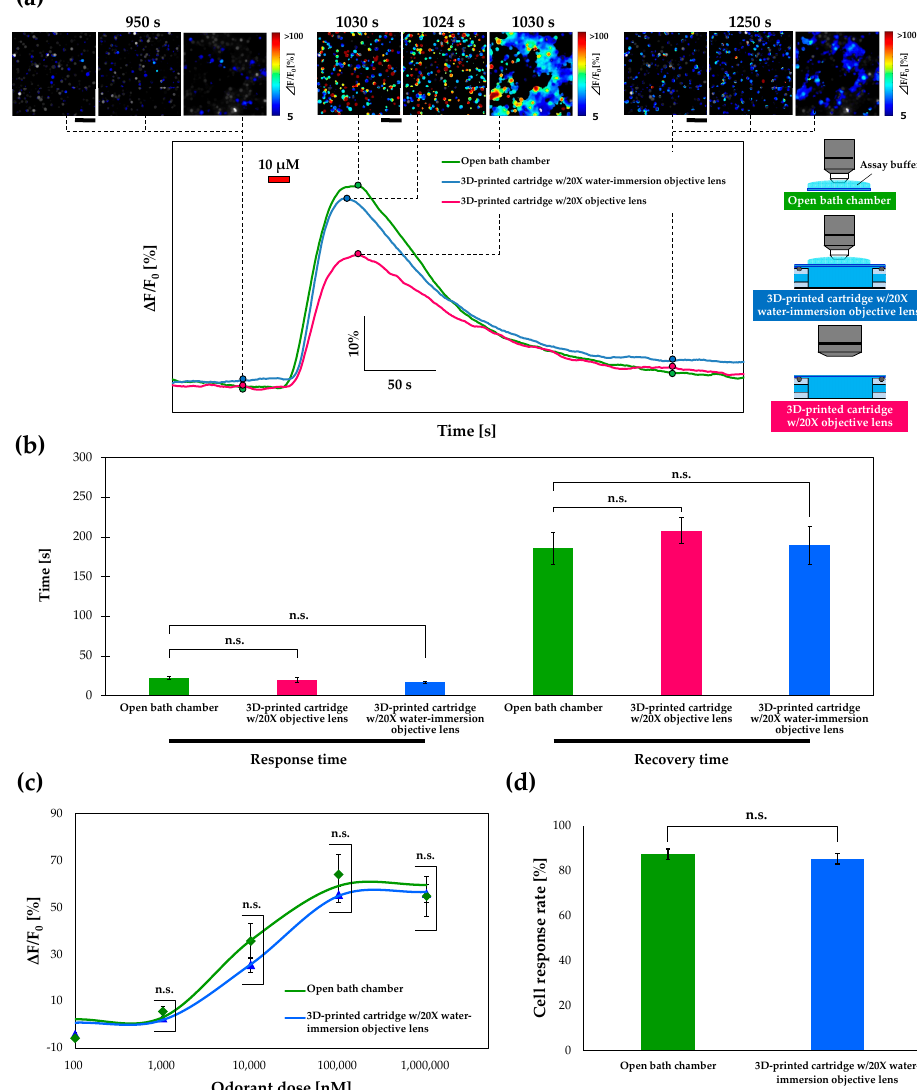
Figure 5. ( a ) Typical fluorescent response of the Or13a cells using the 3D-printed cartridge and a commercial open bath chamber when 10 μ M 1-octen-3-ol stimulations were applied. Upper pseudo- color heat maps of cell-response rates (before stimulation, the peak of fluorescent intensity change, and after stimulation) in a commercial open bath chamber and the 3D-printed cartridge with a 20× water-immersion objective lens or a 20× objective lens exhibited a > 5% increase in fluorescence intensity from the baseline. We defined the start time as 0 s. ( b ) Comparisons between the average response and recovery times for Or13a cells in a commercial open bath camber and in the 3D-printed cartridge with a 20 × water-immersion objective lens or a 20 × objective lens. Data represent the mean ± SEM of fluorescence intensity changes in all cells ( N = 3 individual tests, Welch’s t -test: n.s. = not significant). ( c ) Comparison between the average dose-dependent responses of Or13a cells in the 3D-printed cartridge with a 20 × water-immersion objective lens and in a commercial open bath chamber. The data represent the mean ± SEM of the fluorescence intensity changes in all cells ( N = 4 individual tests, Welch’s t -test; n.s. = not significant). ( d ) Comparison of the cell-response rates of the cells in the 3D-printed cartridge with a 20 × water-immersion objective lens and those in a commercial open bath chamber. The cells in the 3D-printed cartridge exhibited a greater than 5% increase in fluorescence intensity during 10 µ M 1-octen-3-ol stimulation. Data represent the mean ± SEM of the fluorescence intensity changes of the Or13a cells ( N = 4 individual tests, Welch’s t -test: n.s., not